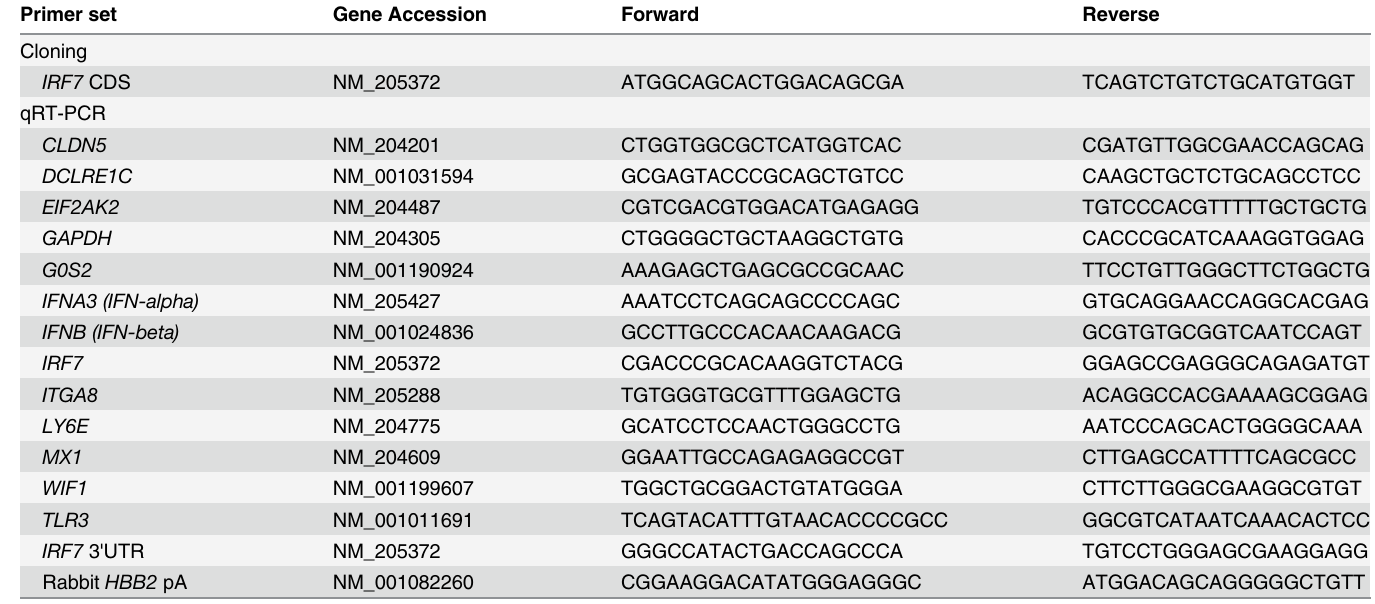
Table 1. List of gene specific PCR primer sequences for cloning and quantitative reverse transcriptase PCR. Primer set Gene